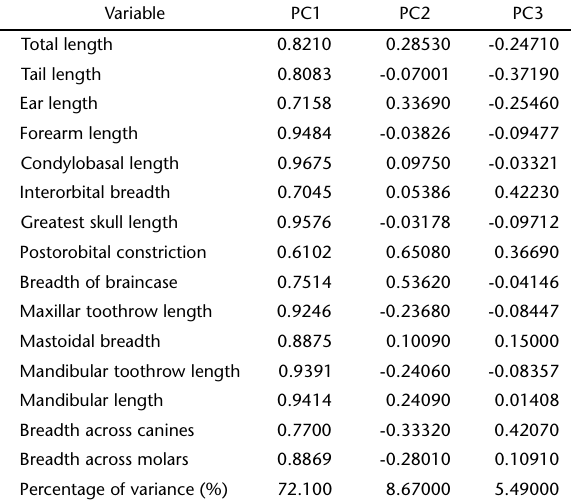
Table IV. External and cranial measurements of Myotis levis levis and Myotis levis dinellii . Averages ± one standard deviation, followed by the sample size in parenthesis and the range within each popula- tion and